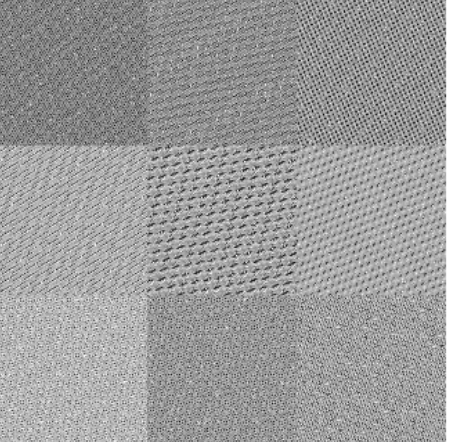
Figure 9. Nine of the ciphered images after Arnold’s map.